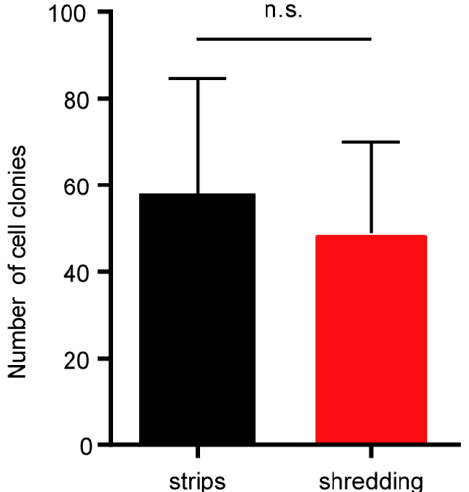
Figure 2. Effects of tissue size on the vitrification of ear tissues. Numbers of cell colonies obtained Figure 2. E ff ects of tissue size on the vitri fi cation of ear tissues. Numbers of cell colonies obtained from different sizes of frozen-thawed tissue. Error bars represent the from di ff erent sizes of frozen-thawed tissue. Error bars represent the SEM.